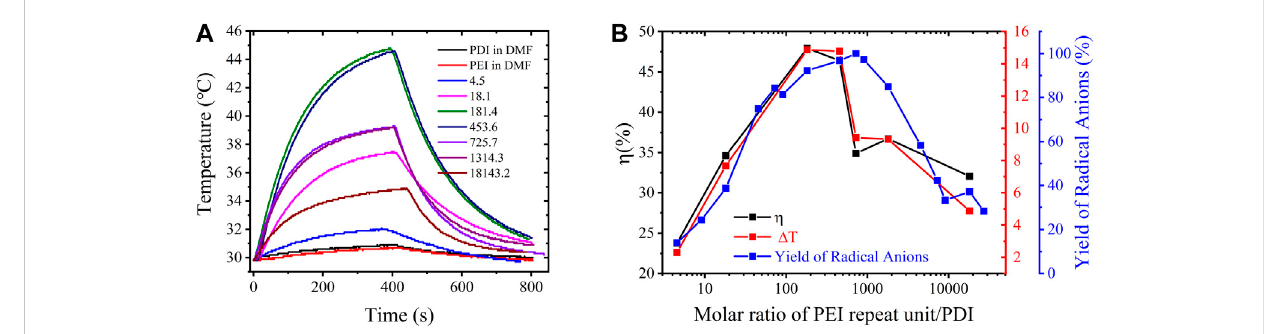
FIGURE 4 Photothermal conversion performance of PEI-PDI suspensions: (A) temperature evolution as a function of time (0 – 400 s) under laser radiation by an 808 nm laser at a power of 1.8 W/cm 2 . PDI (0.04 mg/mL) and PEI (150 mg/mL) in DMF were used as the blank control, PEI-PDI suspensions are of a molar ratio of PEI repeat unit/PDI equals 4.5, 18.1, 181.4, 453.6, 725.7, 1314.3, 18143.2, respectively; (B) the evolution of maximum temperature ( Δ T), photothermalconversionef fi ciency( η )andtheyieldoffreeradicalsinthePEI-PDIsuspensionsasafunctionofthemolarratioofPEIrepeatunit/PDI. The experiment was conducted in a